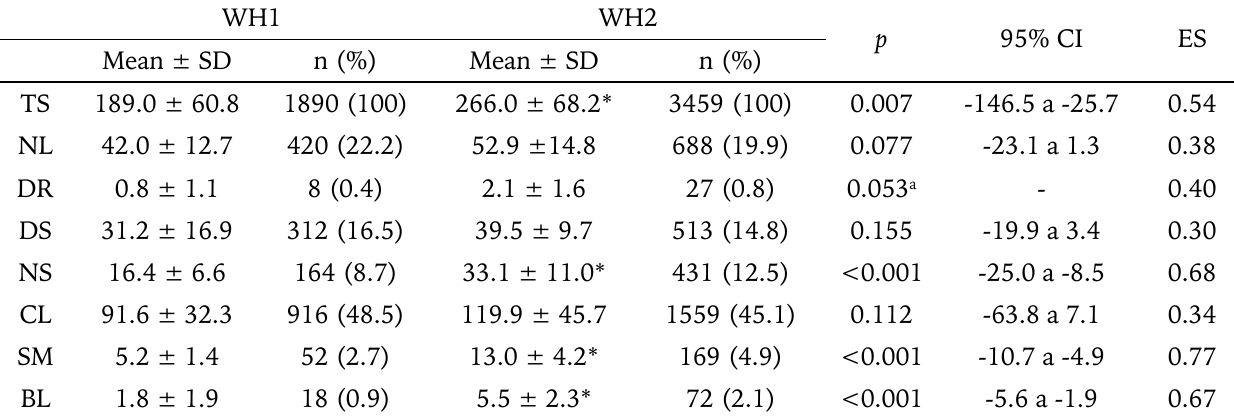
Number of strokes carried out in the classes WH1 and WH2. Data are presented as mean and standard deviation, and as a total number (n) per class with percentage (%). WH1